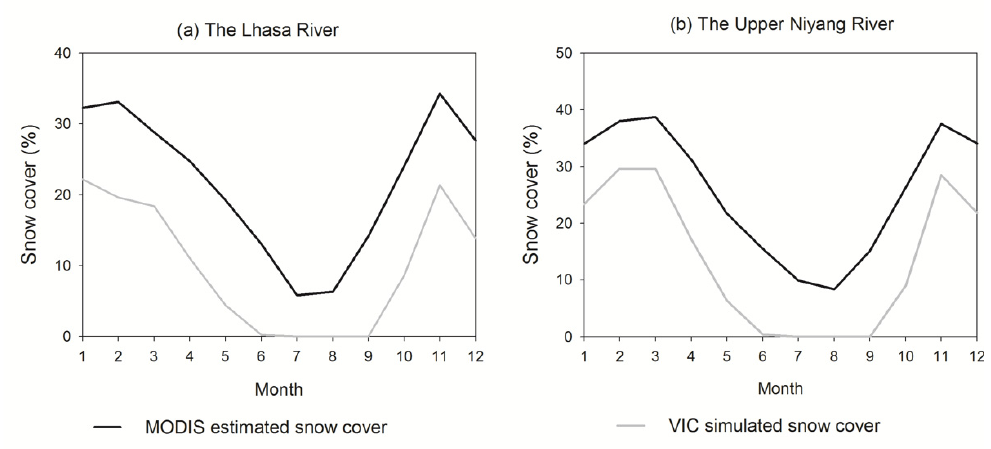
Figure 6. Comparison between MODIS and VIC estimated mean monthly snow cover in the ( a ) LRB and ( b ) UNRB.